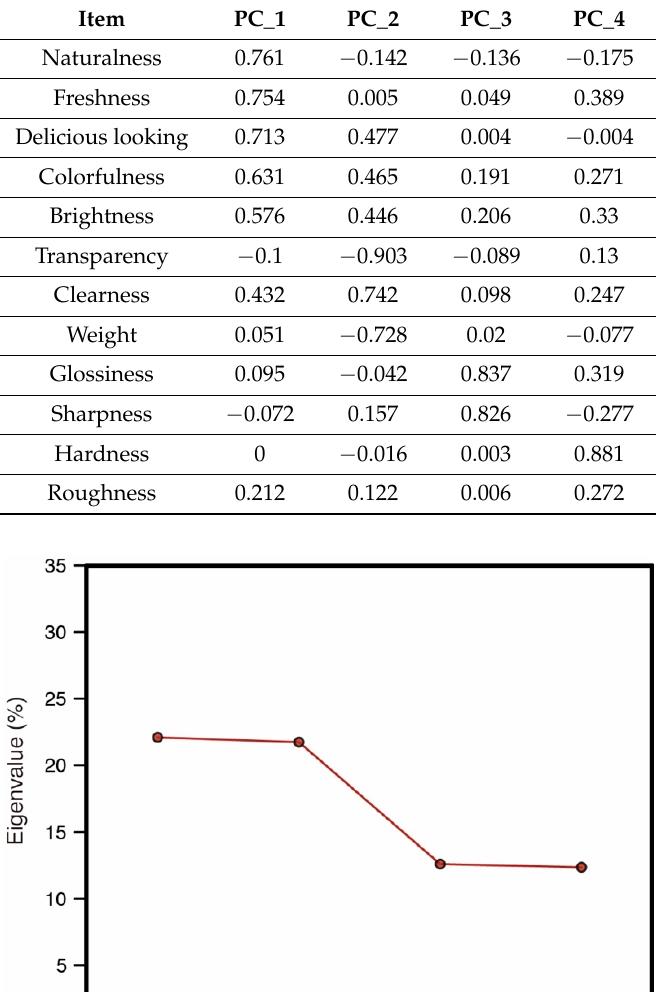
Table 2. Factor loadings of the first four principal components. (after varimax rotation).